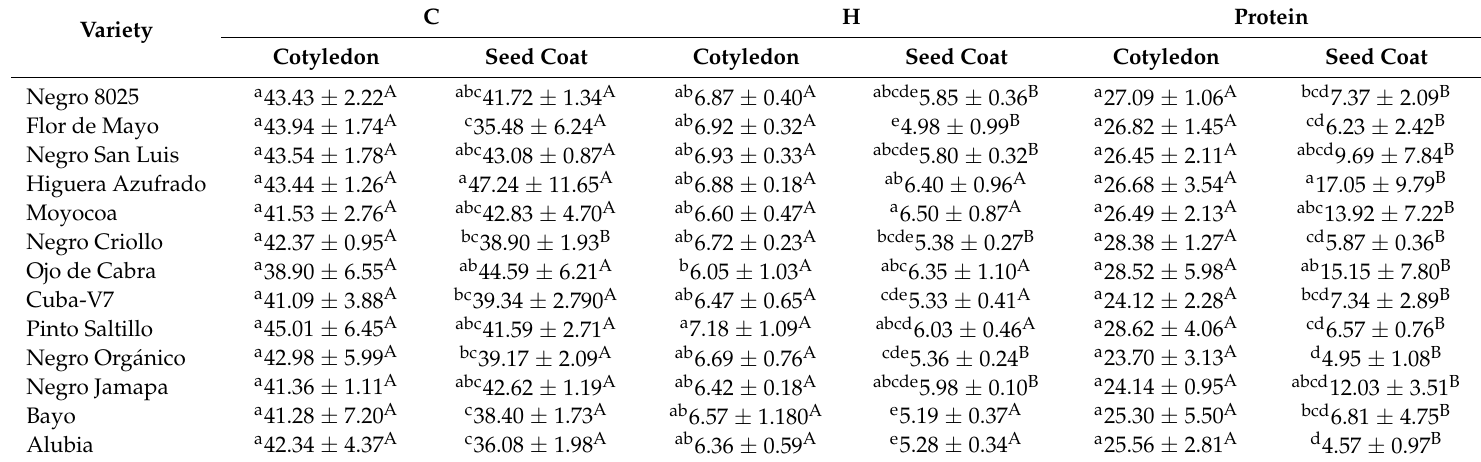
Table 3. Organic elements contained in the seed coat and cotyledon of common bean varieties. C H Protein Variety Cotyledon Seed Coat Cotyledon Seed Coat Cotyledon Seed